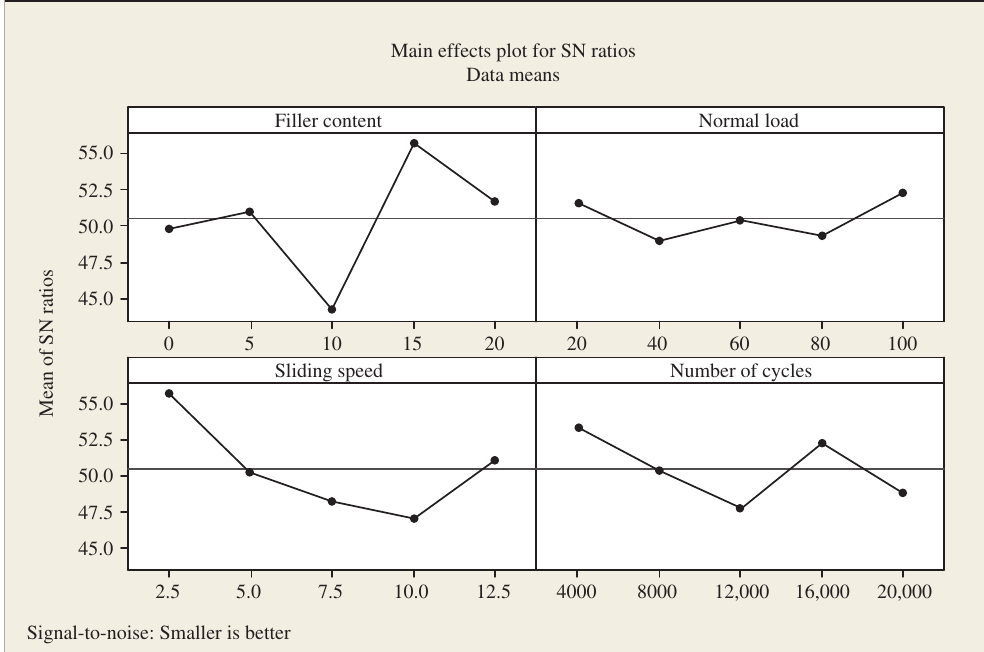
Figure 10: Effect of control factors on the wear rate of nanoalumina-filled dental composites.